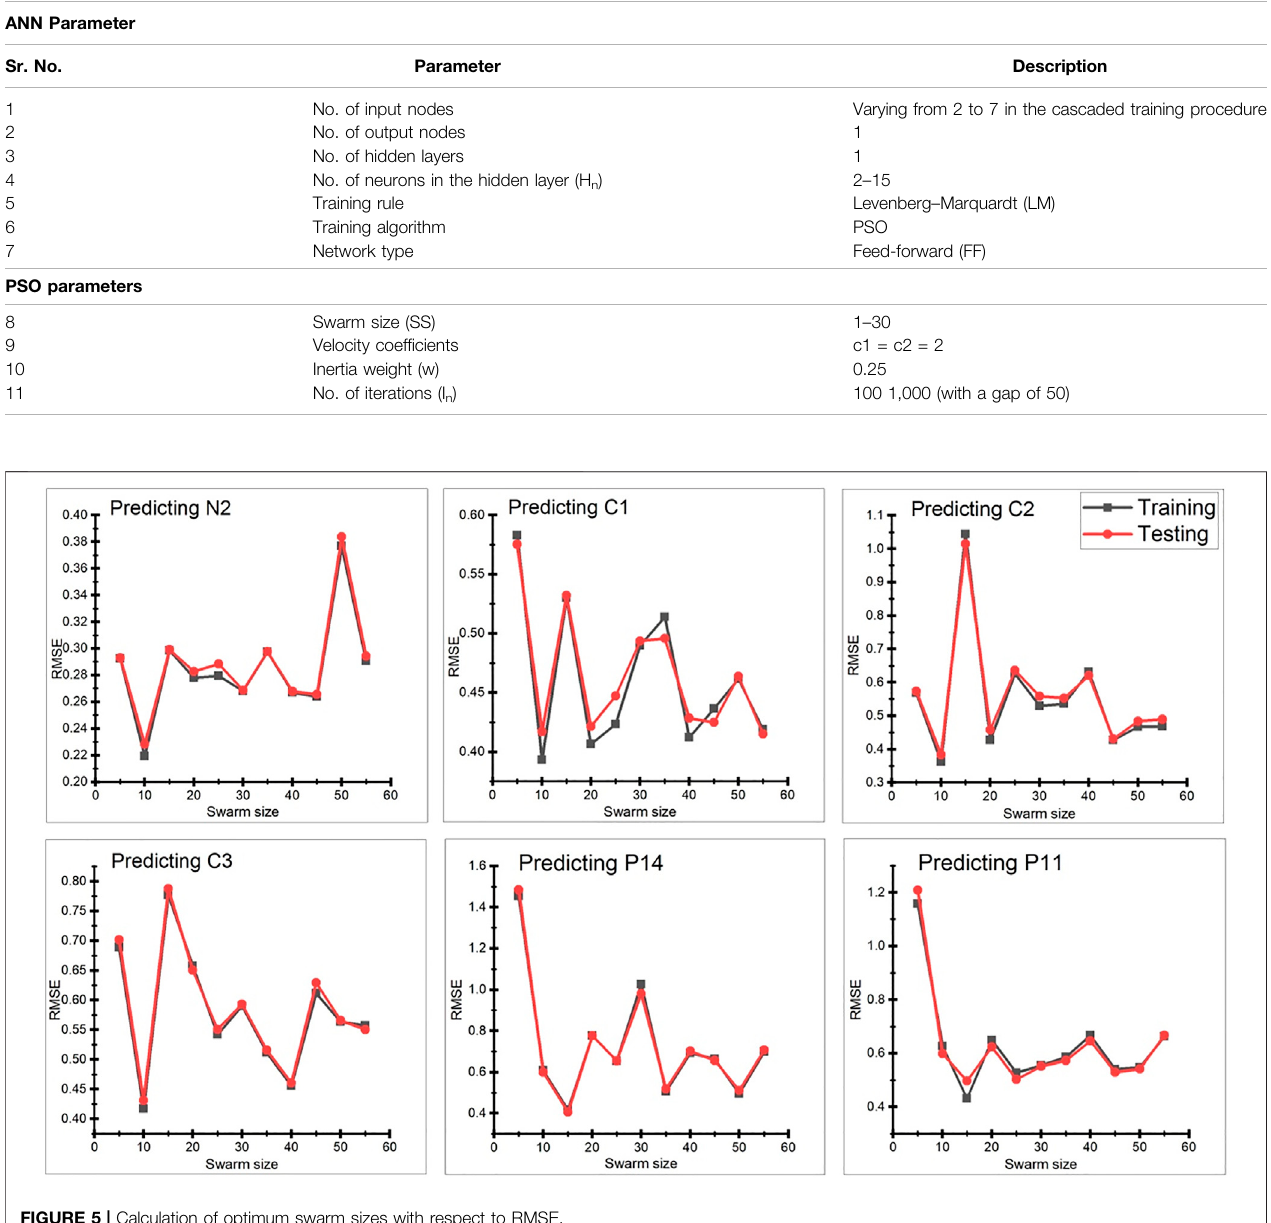
TABLE 10 | Optimum PSO-ANN parameters for the design of the model.